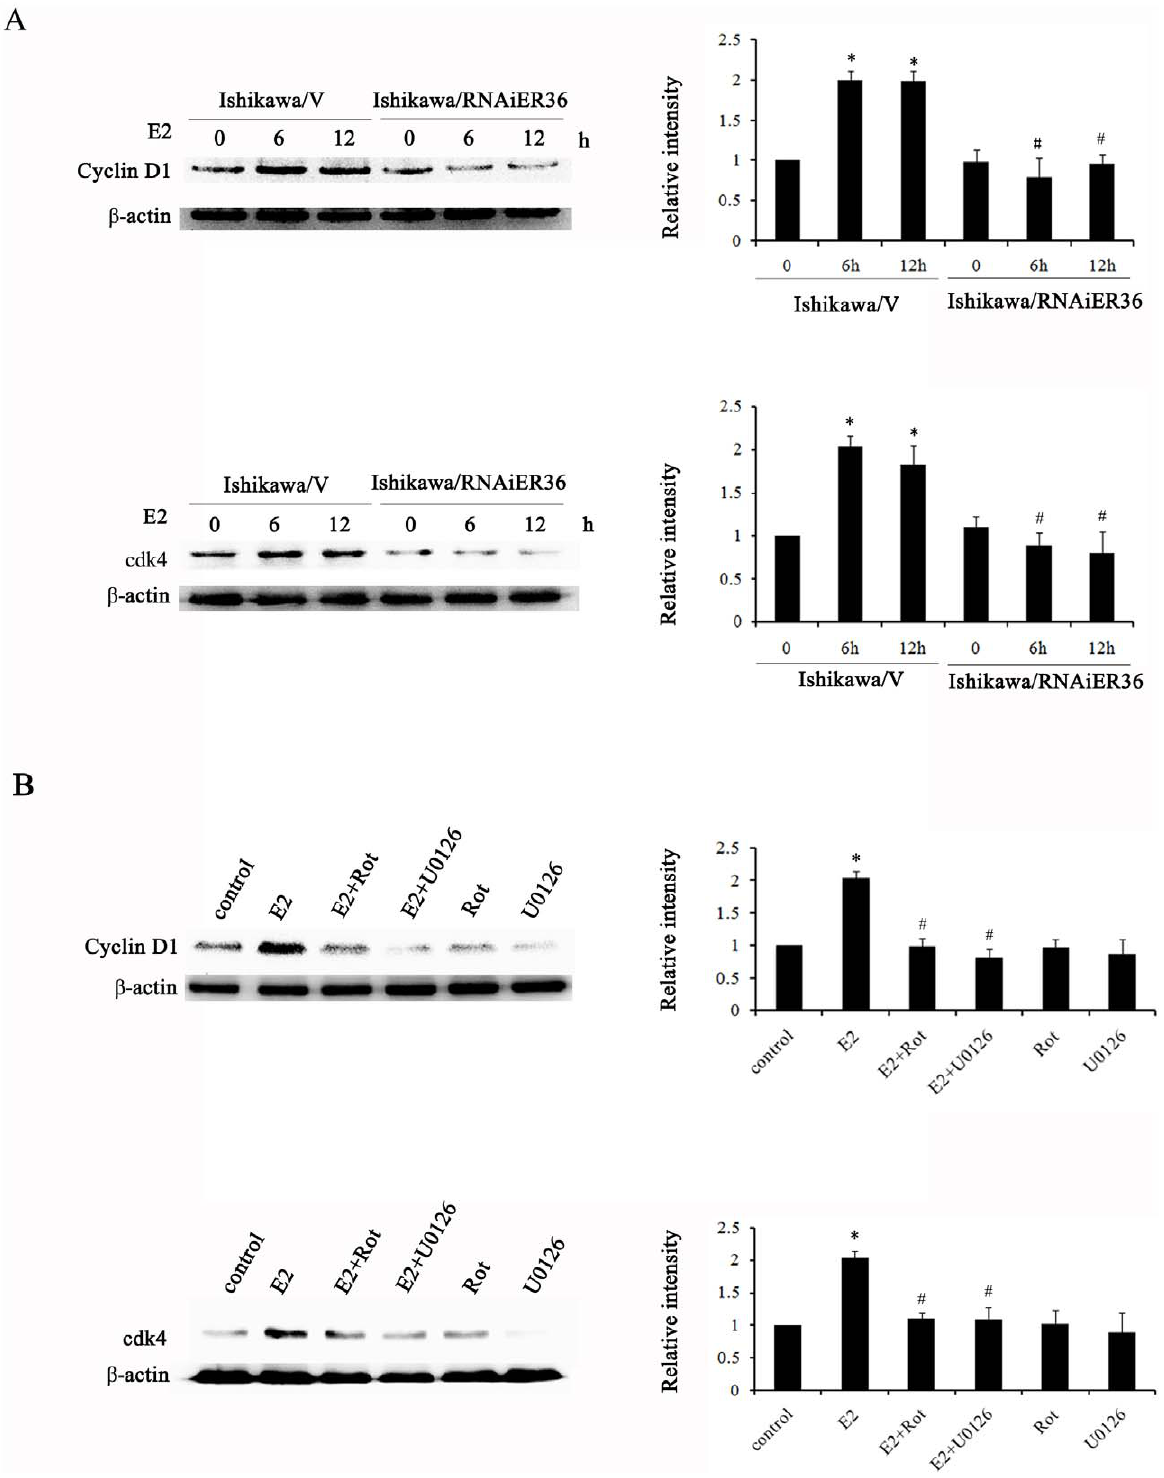
Figure 5.ER- a 36 mediates E2-stimulated cyclin D1 expression. A. Western blot analysis of cyclin D1 and cdk4 expression in Ishikawa/V and Ishikawa/RNAiER36 cells treated with 10 nM E2 for 6 h and 12 h. Levels of cyclin D1 and cdk4 expression were normalized to the levels of b -actin, and each bar represents mean value 6 SEM (n=3). *, P , 0.05 compared to untreated cells. # , P , 0.05 compared to E2-treated Ishikawa/V cells. B. Ishikawa cells were treated for 12 h with E2 or together with 5 m M of PKC d inhibitor rottlerin or 10 m M MEK inhibitor U0126. Levels of cyclin D1 and cdk4 expression were normalized to the levels of b -actin, and each bar represents mean value 6 SEM (n=3). *, P , 0.05 compared to untreated cells. # , P , 0.05 compared to E2-treated Ishikawa cells.